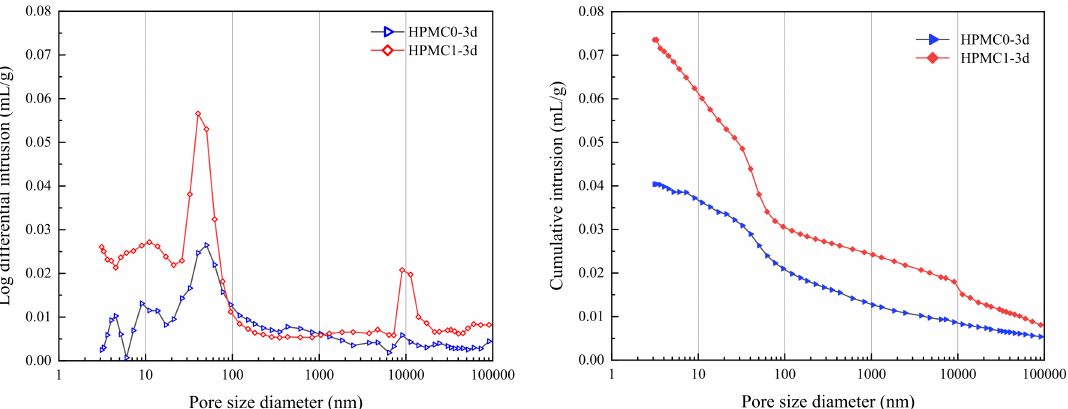
Figure 7. The pore structure of HPMC0 and HPMC1 at 3 days.